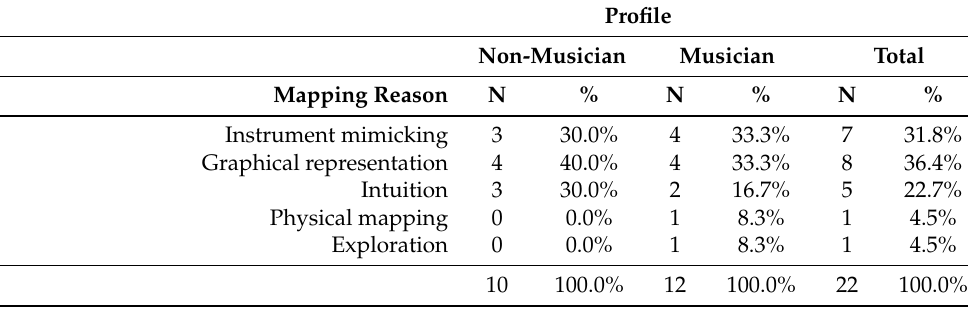
Table A19. Mapping rationale—stimulus c.